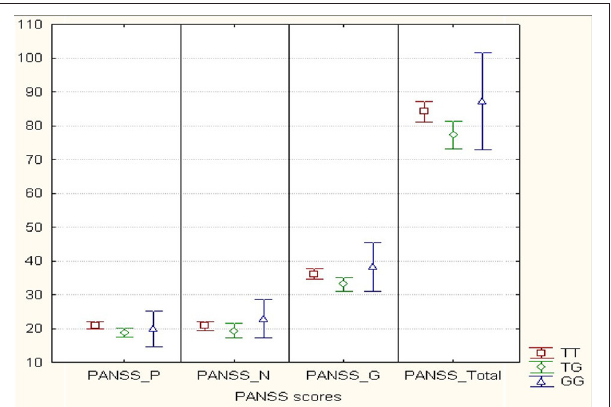
FIGURE 2 | Mean values (score) of positive, negative and general psychopathology subscales of PANSS according to MIR137 rs1625579 polymorphism in schizophrenia patients. Comment: Graphic elements reflect Mean + 0.95 CI; X-axis is expressed in score values and Y-axis contains four totals of positive (PANSS_P), negative (PANSS_N), general psychopathology (PANSS_G) items and total index for all subscales (PANSS_Total). Sample volume: TT - 91 subjects, TG - 49 subjects, GG - 10 subjects. P -value < 0.05 for PANSS_P, PANSS_G and PANSS_Total.